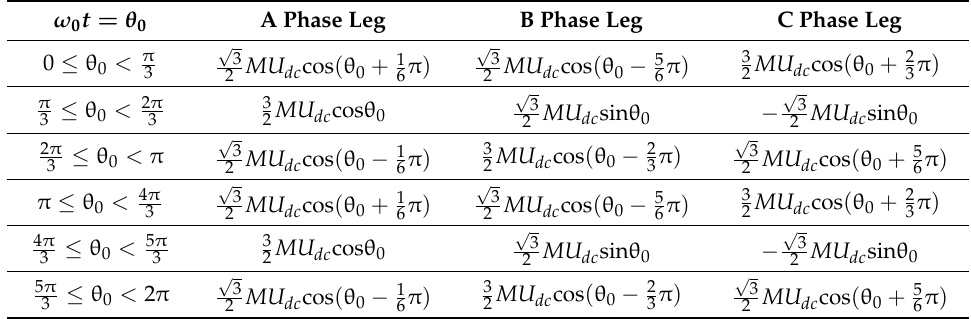
Table 2. Phase reference voltage for SVPWM.